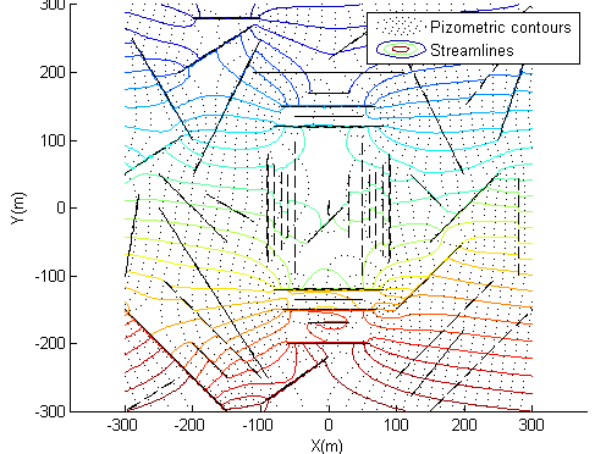
Figure 6. 50 fractures with different hydraulic conductivities, apertures and lengths having parame- ters prescribed in Table 3.